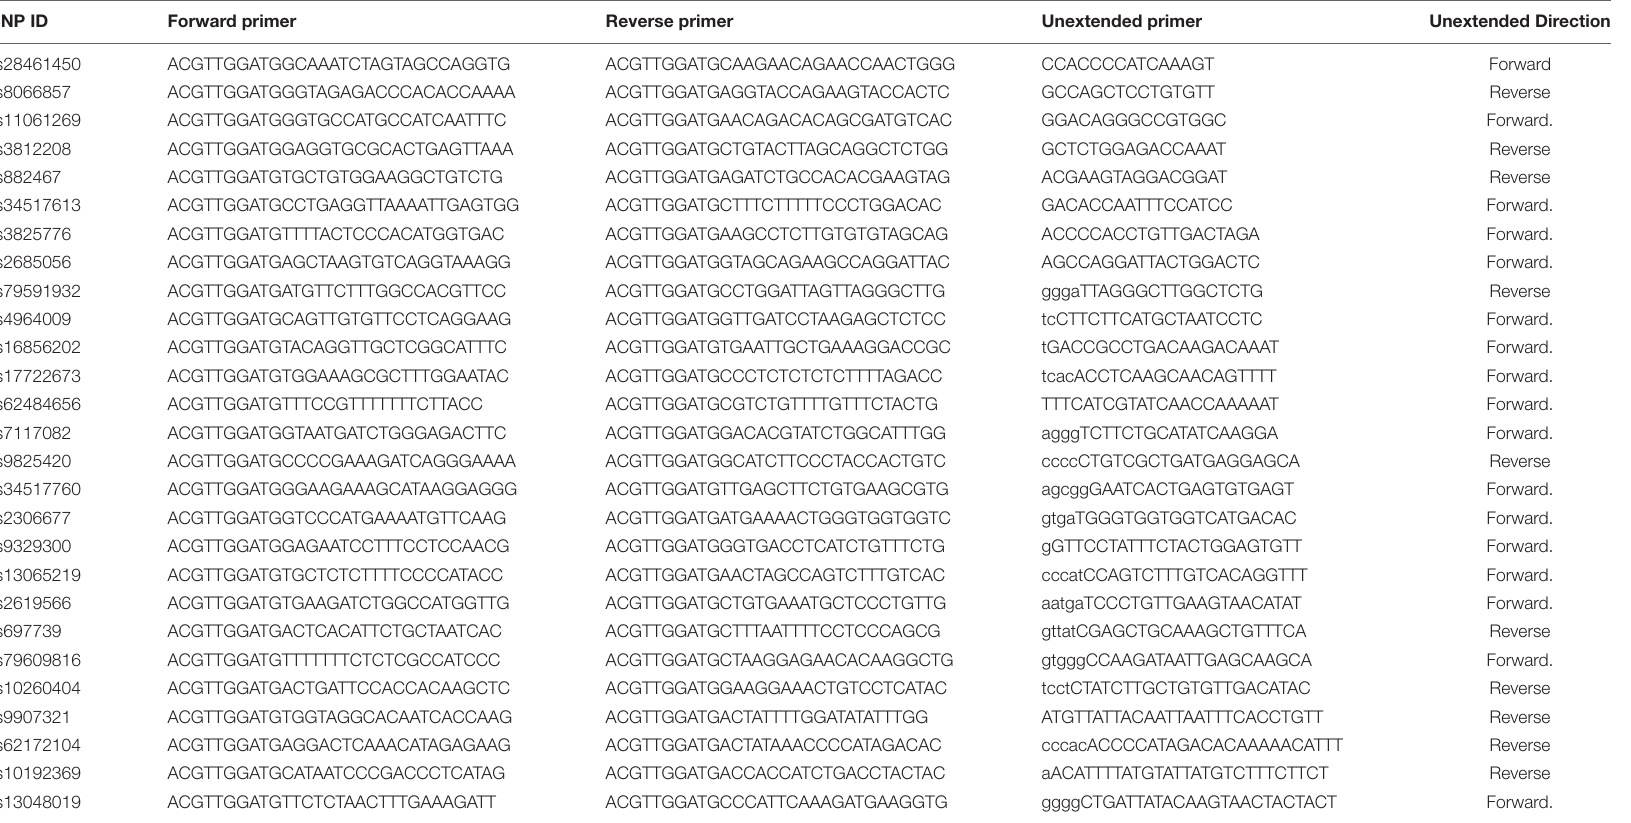
TABLE 2 | Primer sequences genotyped by